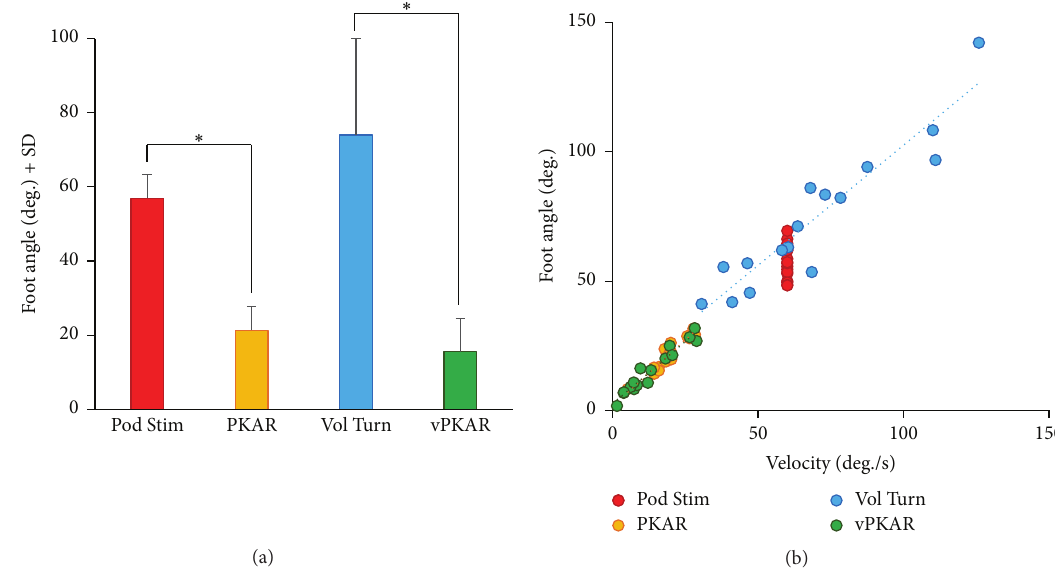
Figure 6: Foot angle (a) and its correlation with body rotation velocity (b). The mean foot yaw angle (a) between two consecutive stance phases was similar for podokinetic stimulation and voluntary turning. During the two posteffects, the mean angle diminished. In panel (b), the mean foot angle of each subject was plotted against the mean rotation velocity while stepping, for all conditions. There was a good relationship between foot angle and subject’s angular velocity, both during voluntary turning and during the two posteffects. ∗ indicates significant difference ( 𝑝 < 0.05 ) between mean foot angles